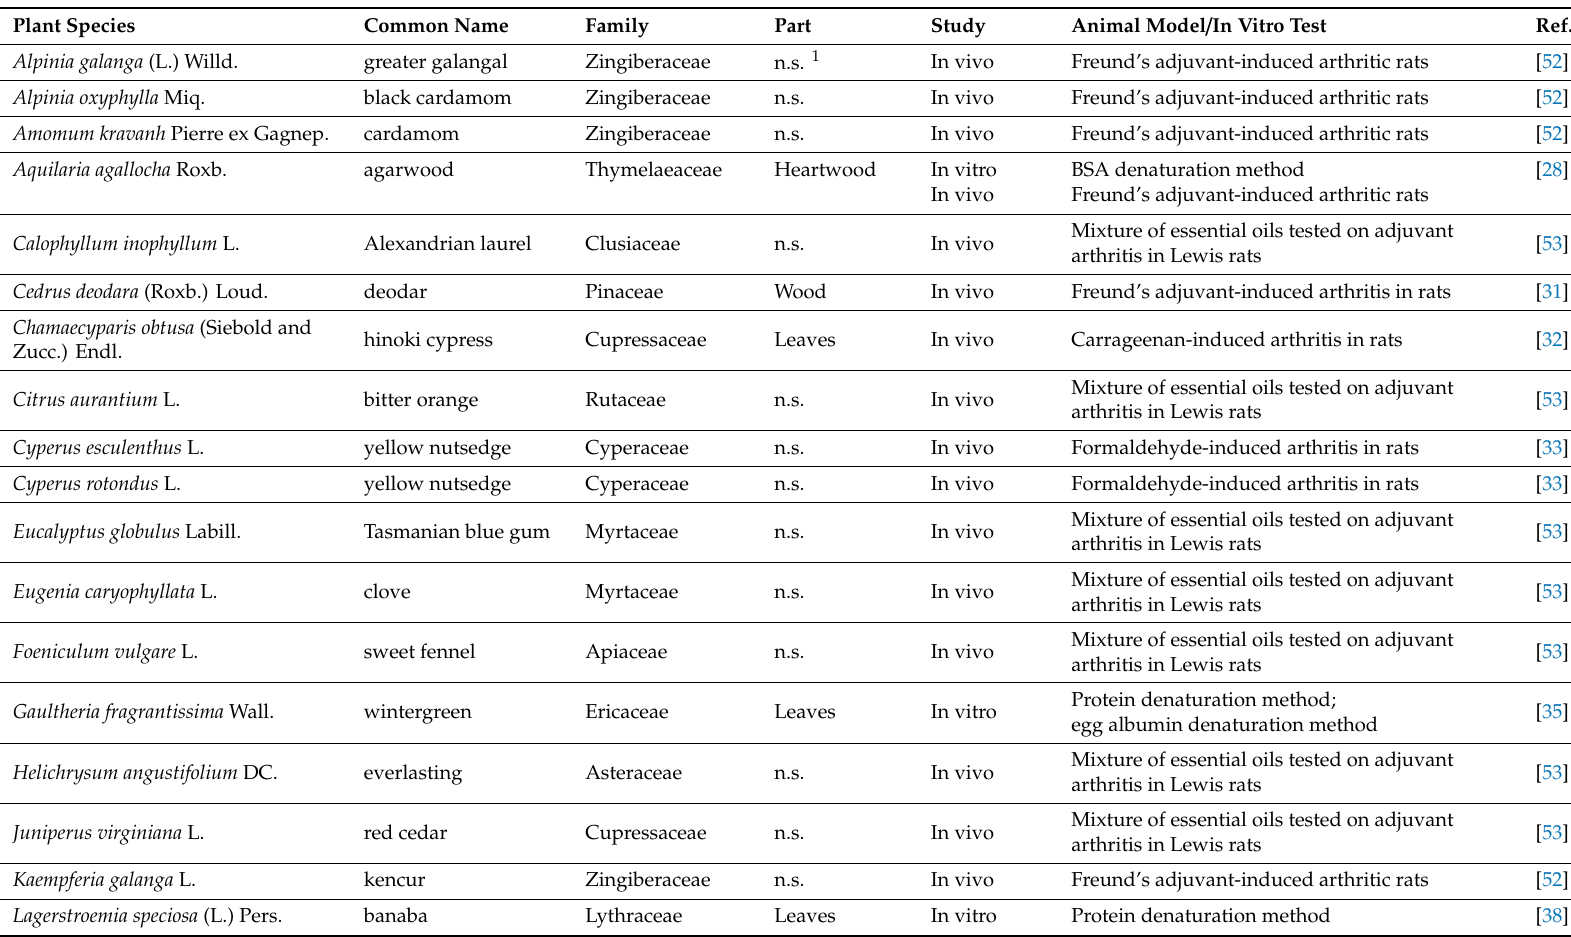
Table 1. Essential oils investigated for their antiarthritic